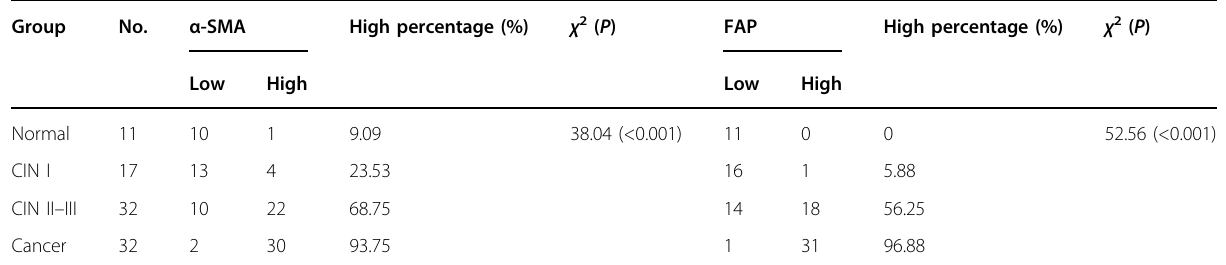
Table 1 Correlation of α -SMA or FAP expression with carcinoma progression.